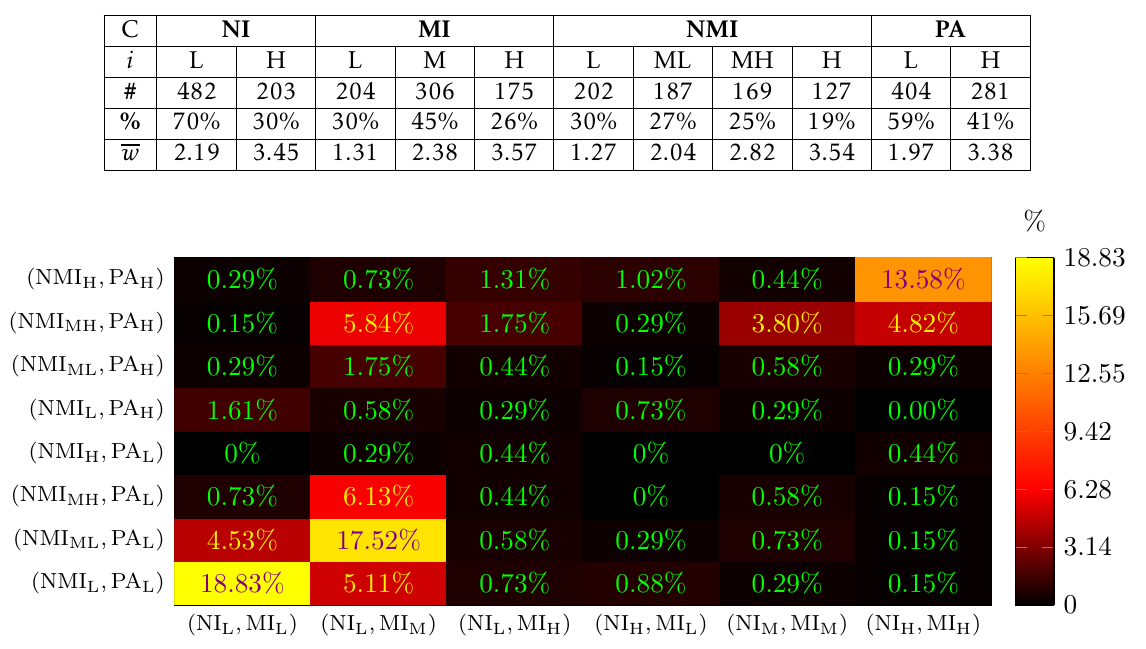
Table 5. The size # (i.e., the number of participants), the percentage and the average data-sharing willingness level w ∈ [1 , 5] of all clusters (C = nudging condition).